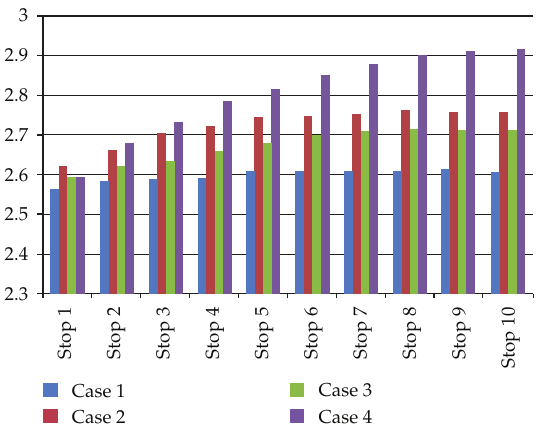
Figure 3: Average passenger wait time at each